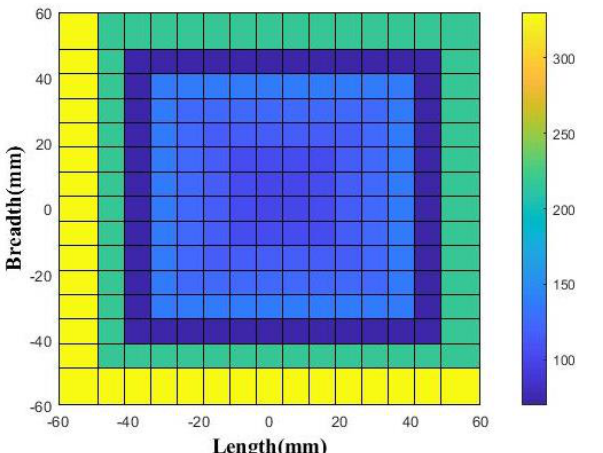
Figure 6. Arrangement of phase throughout the aperture distribution for the generation of the five-layer prototype.